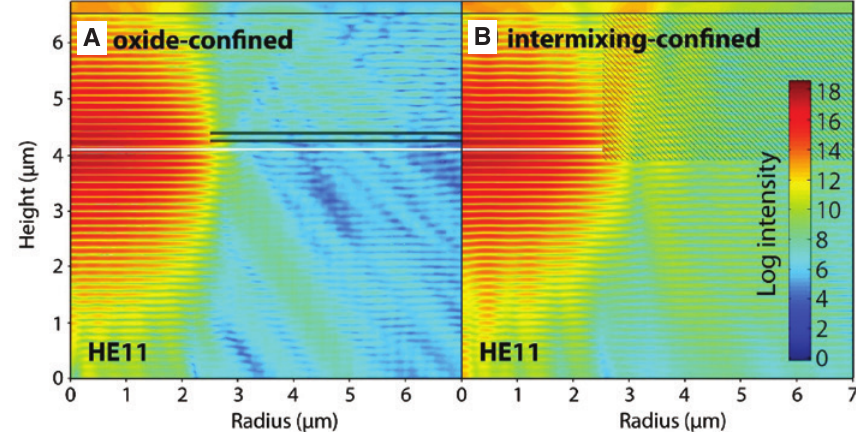
Figure 11: Simulated cross-section of the electric field intensity distribution of the fundamental (HE11) mode in 5 μ m aperture (A) oxide-confined and (B) impurity intermixing-confined devices. White lines represent the active region, thick black lines point to the oxide apertures, and hatching marks the area where the material was intermixed. The thin black line on top of the VCSEL represents the surface of the